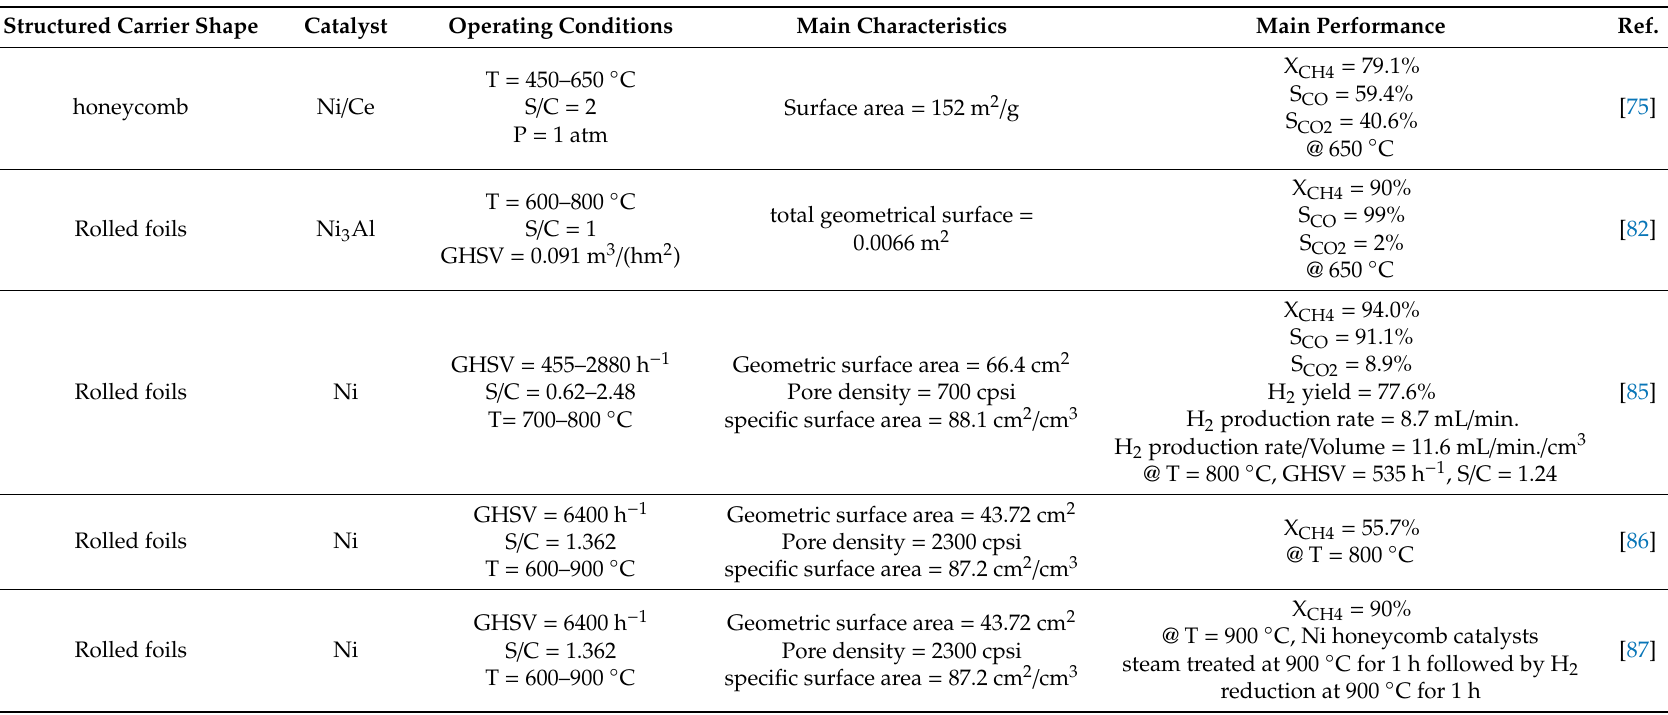
Table 4. Summary of the main performance of the catalysts supported on ceramic